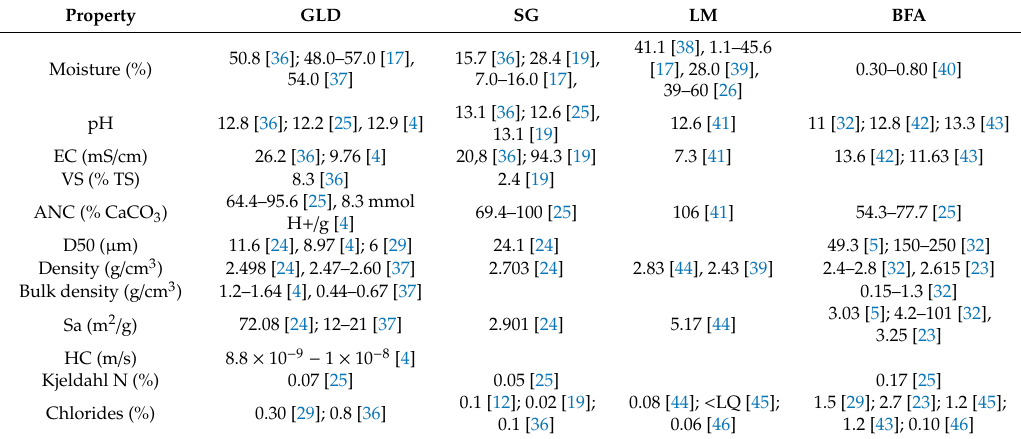
Table 4. Other relevant physicochemical properties to select technological